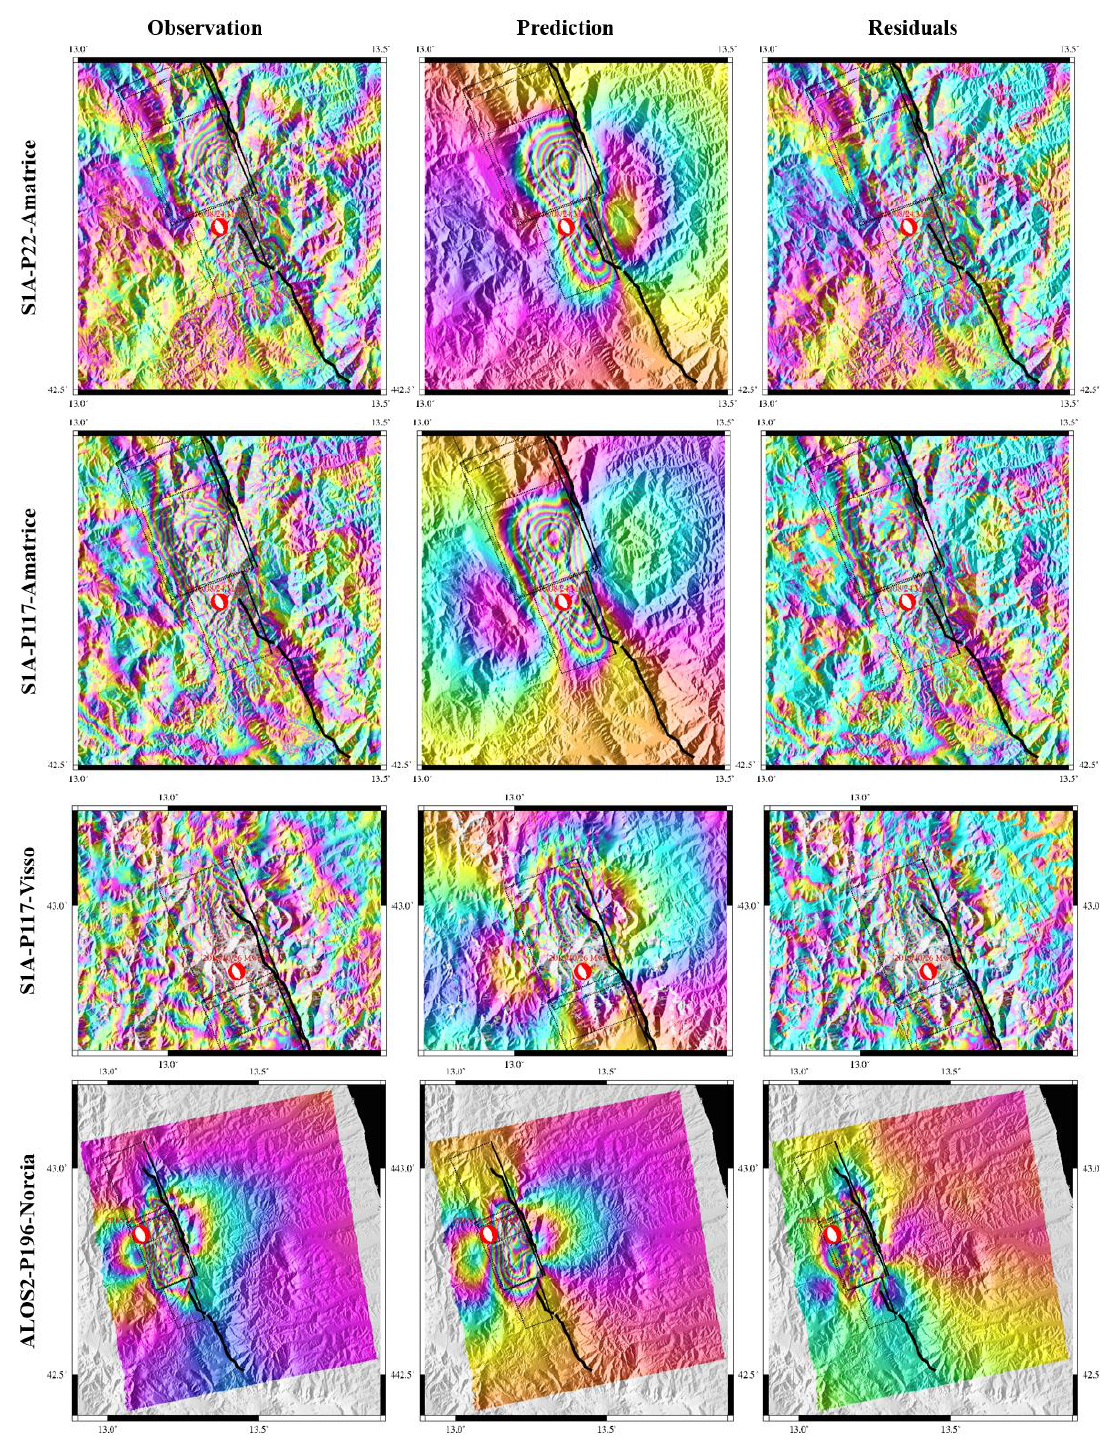
Figure A1. SAR Interferograms, predictions, and residuals based on the joint slip models derived in this study for the Central Italy earthquake sequence. The S1A interferograms are wrapped to 2.8 cm, and the ALOS interferogram is wrapped to 11.45 cm. The red beach ball in each interferogram represents the location and focal mechanism of the corresponding event.